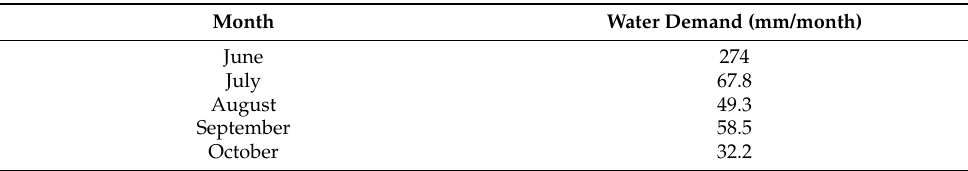
Table 1. Water demand for the grown rice in each month.